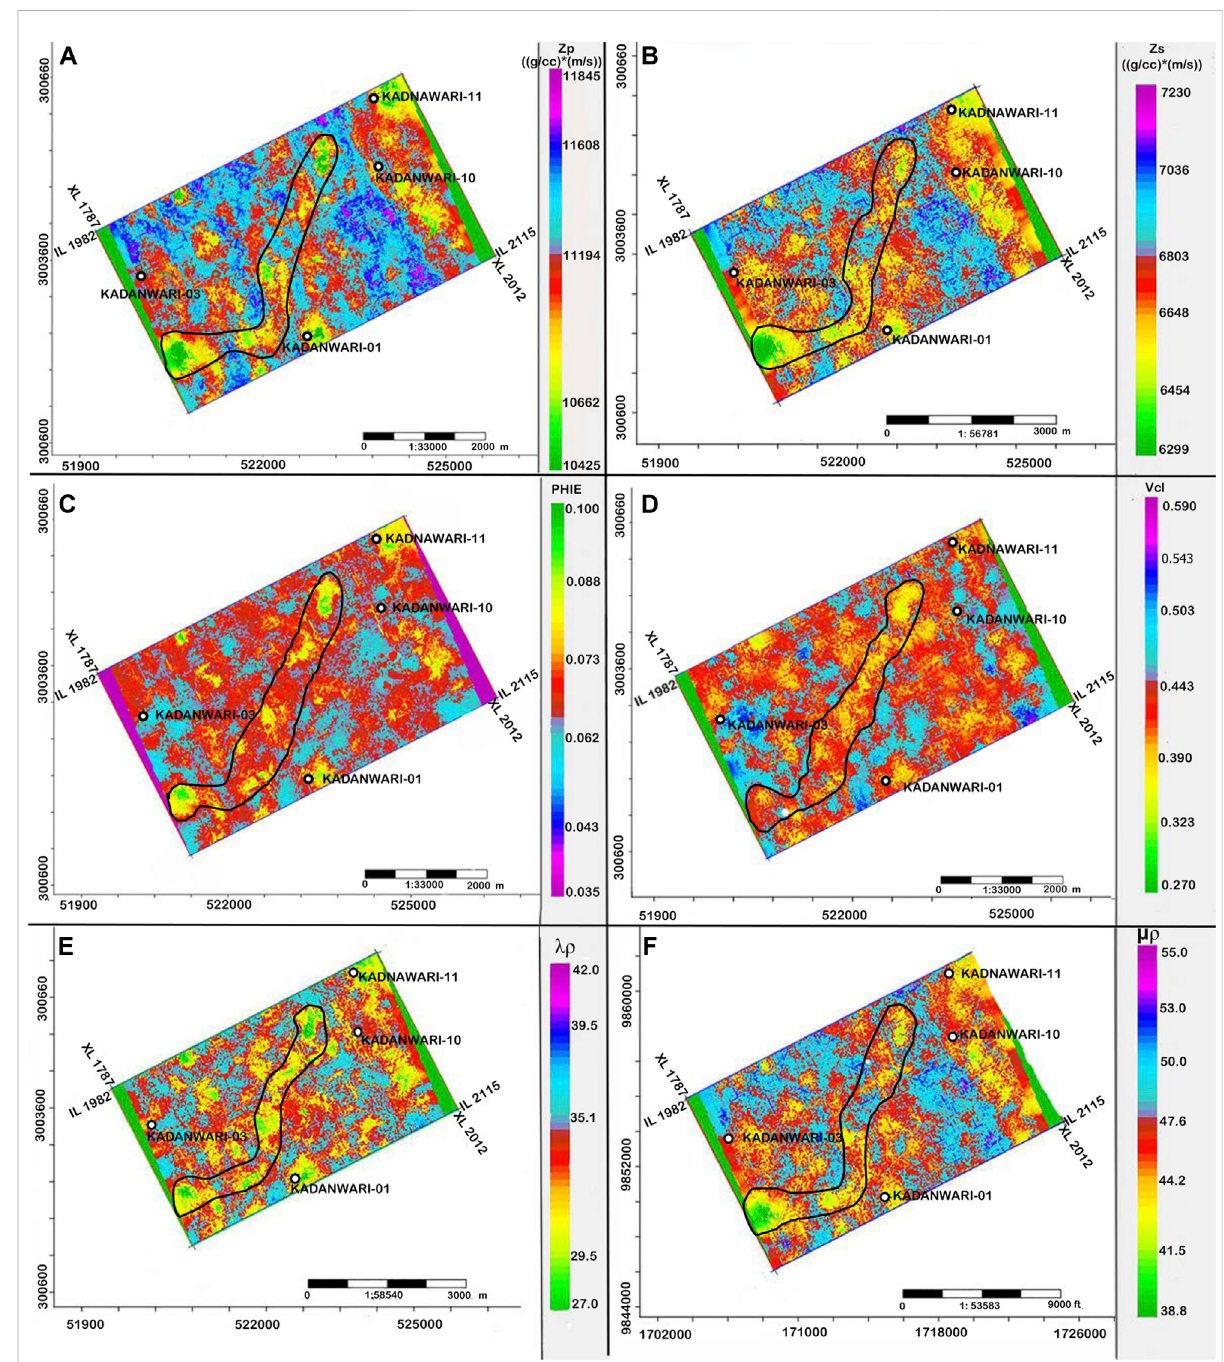
predictors with low uncertainties in the prediction, with R 2 and adjusted R 2 around 0.95 and RMS error around